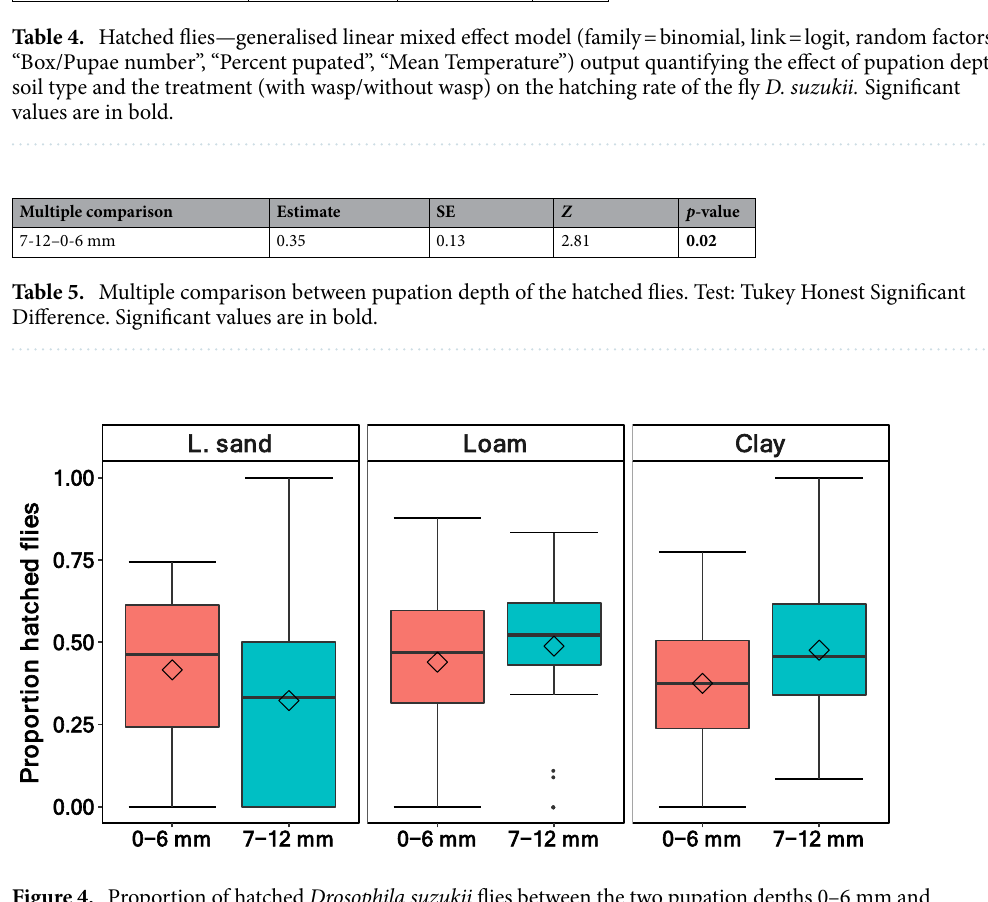
Figure 4. Proportion of hatched Drosophila suzukii flies between the two pupation depths 0–6 mm and 7–12 mm and the three soil types (loamy sand, loam and clay; n = 96 as waps and control treatments showed no